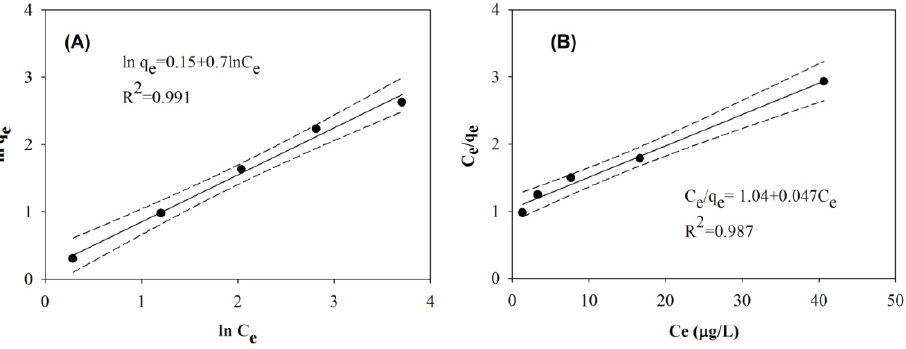
Figure 5. Linear regression of Freundlich ( A ) and Langmuir ( B ) isotherms with 95% confidence interval. Table 2. Isotherm constants for As(III) adsorption onto FeOOH coated sand. Freundlich Langmuir